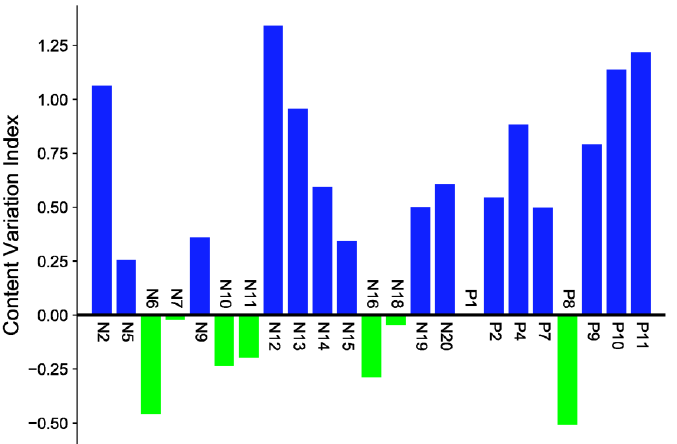
Figure 5. Content change of chemical components in Sanguisorba officinalis L. before and after processing.